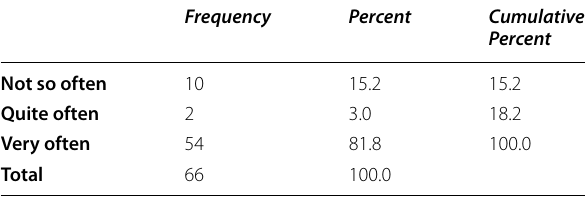
Table 2 How often do you travel to unknown places in a year?